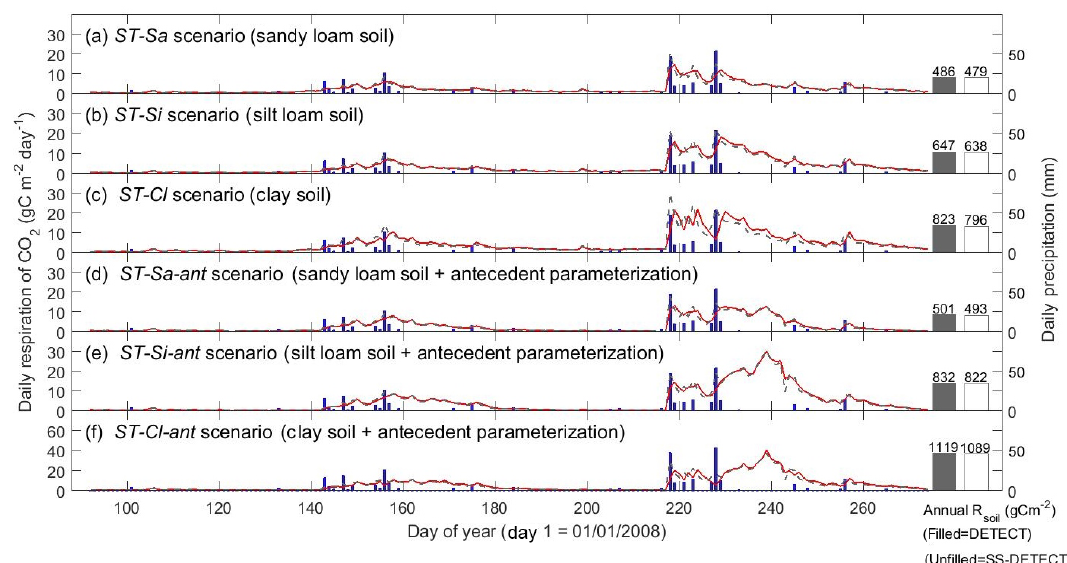
Figure 3. Time series of daily surface soil respiration ( R soil ) predicted from the non-steady-state (NSS) DETECT model (red solid lines) and the steady-state (SS-DETECT) model (grey dashed lines), for different soil texture scenarios. The first three scenarios are the same as the control (Ctrl), except they assume a different soil texture: (a) more sandy soil, (b) more silty soil, or (c) more clayey soil. Panels (d) , (e) , and (f) show the R soil predictions from the same soil texture scenarios as in (a) – (c) , but also include the antecedent effects of soil moisture and temperature. See Table 2 for descriptions of each scenario. R soil predictions are overlaid with daily precipitation.